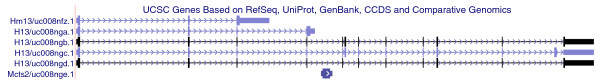
Isoform structures of H13 and Mcts2. Labeled graphical depiction of H13 and Mcts2 UCSC isoform structures.